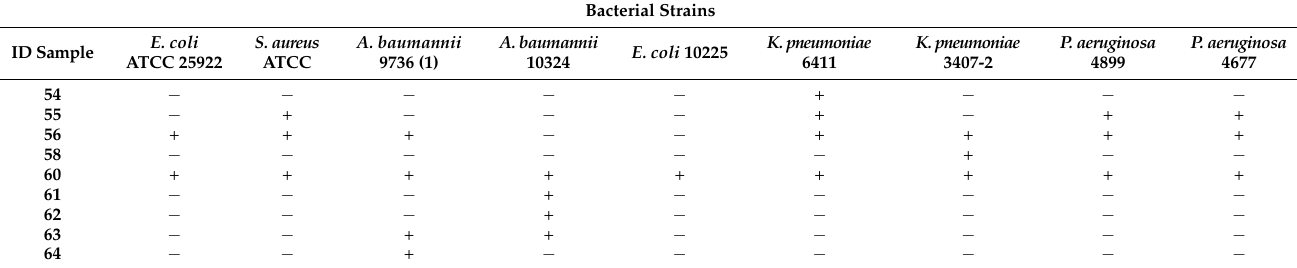
Table 3. Biological assays for compounds isolated from Ipomoea sp. towards different bacterial strains. For each bacterial strain, essays marked as (+) were positive and ( − ) negative in susceptibility tests. Bacterial